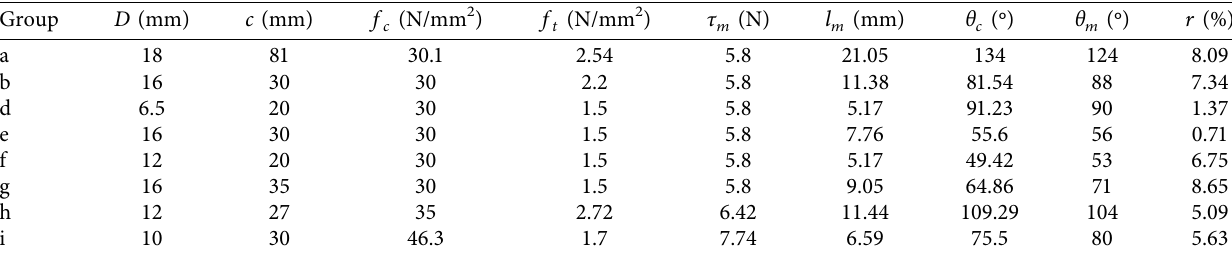
Figure 7: Location of corrosion cracks in reinforced concrete. (a) Scan image of the specimen of the middle reinforcement [22]. (b) Crack development paths with different thicknesses of cover [22]. (c) The crack form of plate type test [27]. (d) Simulating the development of corrosion cracks in the middle reinforcement [28]. (e) Simulation and test of steel corrosion with different covers [29]. (f) Results of cracking tests of corner reinforcement ( d � 12mm; c � 20 mm) [30]. (g) Results of cracking tests of corner reinforcement ( d � 12mm; c � 20mm) [30]. (h) Finite element simulation different covers [31]. (i) Cross-section corrosion crack pattern with development with of non-central of crack reinforcement Table 2: Crack spacing data comparison and error.